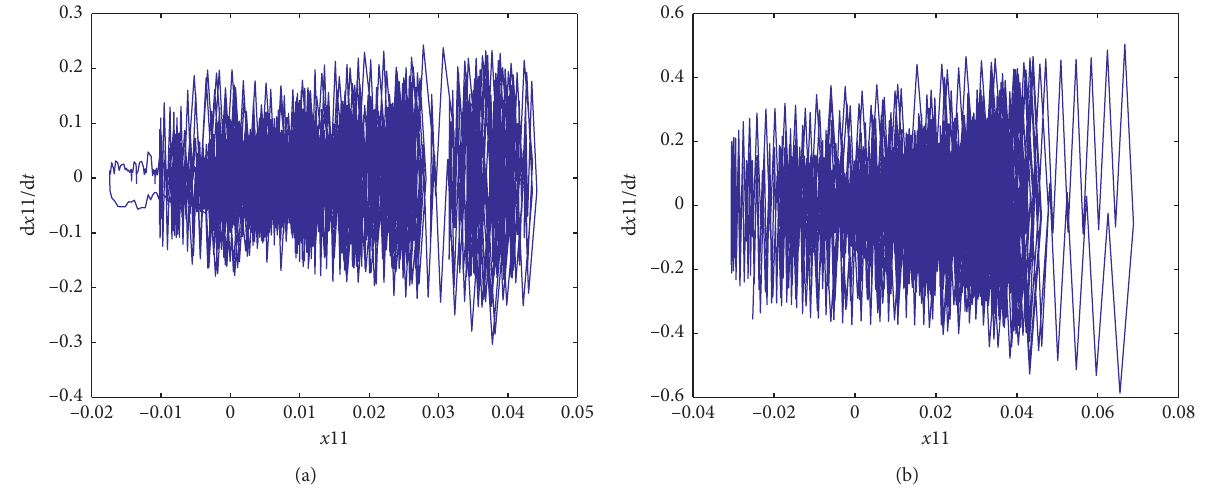
Figure 21: Related phase portrait of Figure 20.